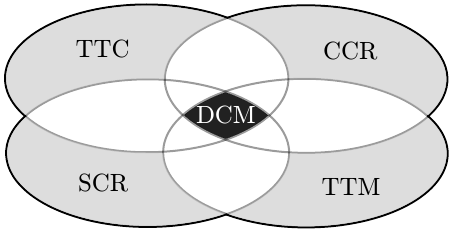
Figure 10: Four interorganisational core processes and demand chain management as a fifth intersecting process creating and interdependent